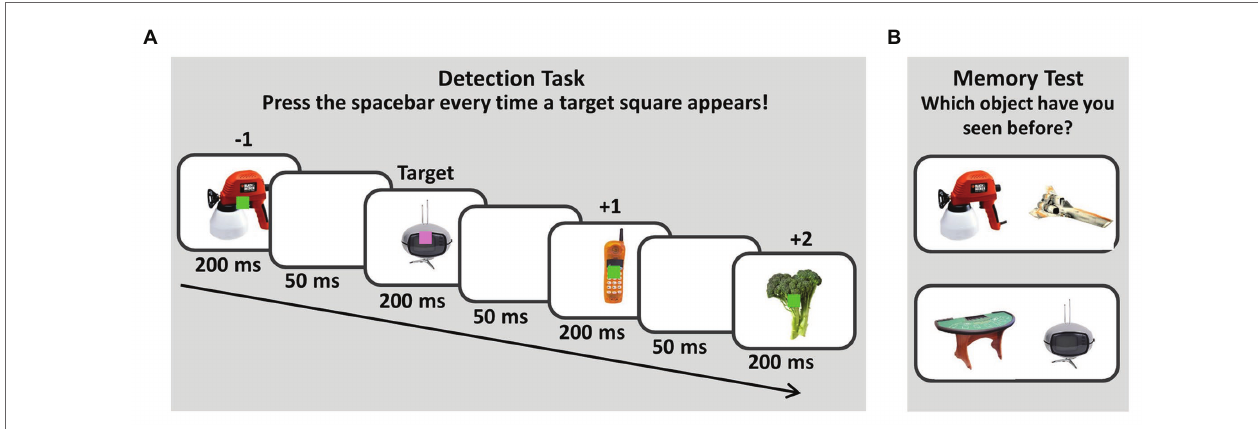
FIGURE 1 | Memory paradigm. The experiment consisted of two phases. In an initial detection task depicted in (A) participants viewed a rapid stream of pictures presented at the center of the screen, overlapped by a colored square. Participants were asked to press the spacebar as quickly as possible whenever they saw a target square (here: pink) and to make no response whenever the distractor square appeared (here: green). Half of the participants knew that their memory for the pictures would be tested later ( intentional encoding ), while the other half of the participants was asked to ignore the pictures as good as possible ( incidental encoding ). After completing the detection task, participants performed a two-alternative-forced-choice recognition test, depicted in (B) . On each trial, a previously presented picture was paired with a new picture. Participants were asked to indicate which of the two pictures they had seen before by pressing one of two